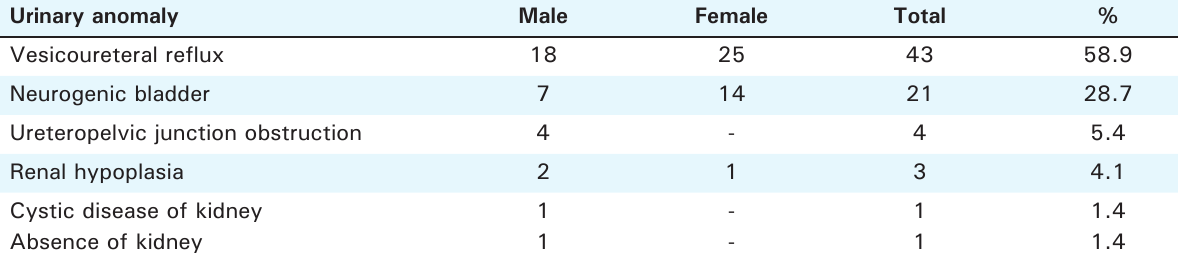
table 3. Urinary tract anomalies (UtA) among patients with complicated UtIUrinary tract anomalies (UtA) among patients with complicated UtI